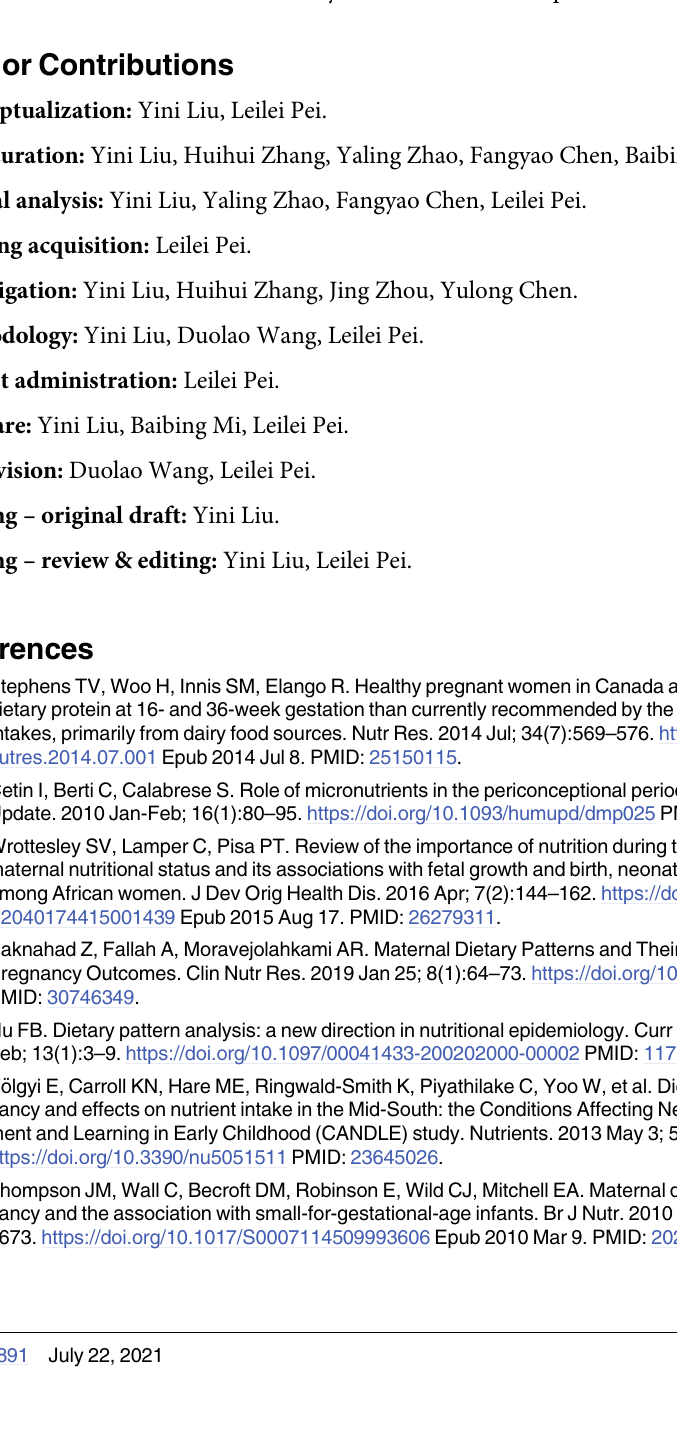
S11 Fig. Geographical distribution of adjusted ORs of prudent pattern of T3, as associated with prevalence of macrosomia. (TIF) S1